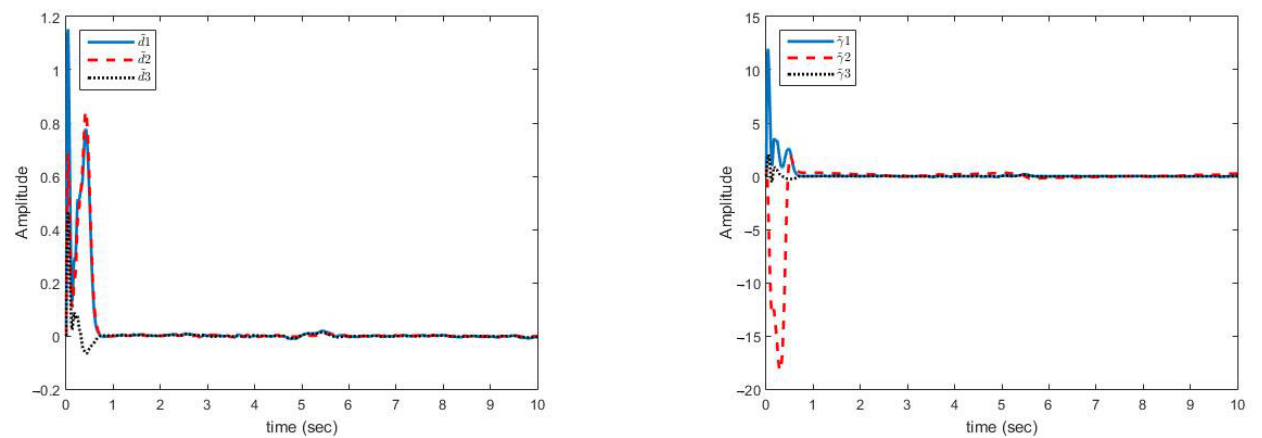
Figure 7. Estimation error curves of bounds related to uncertainties ( right ) and disturbances ( left )—(case B). Case C . Multi-mode synchronization, taking into account the disturbance and uncer- tainties bounded with the function :